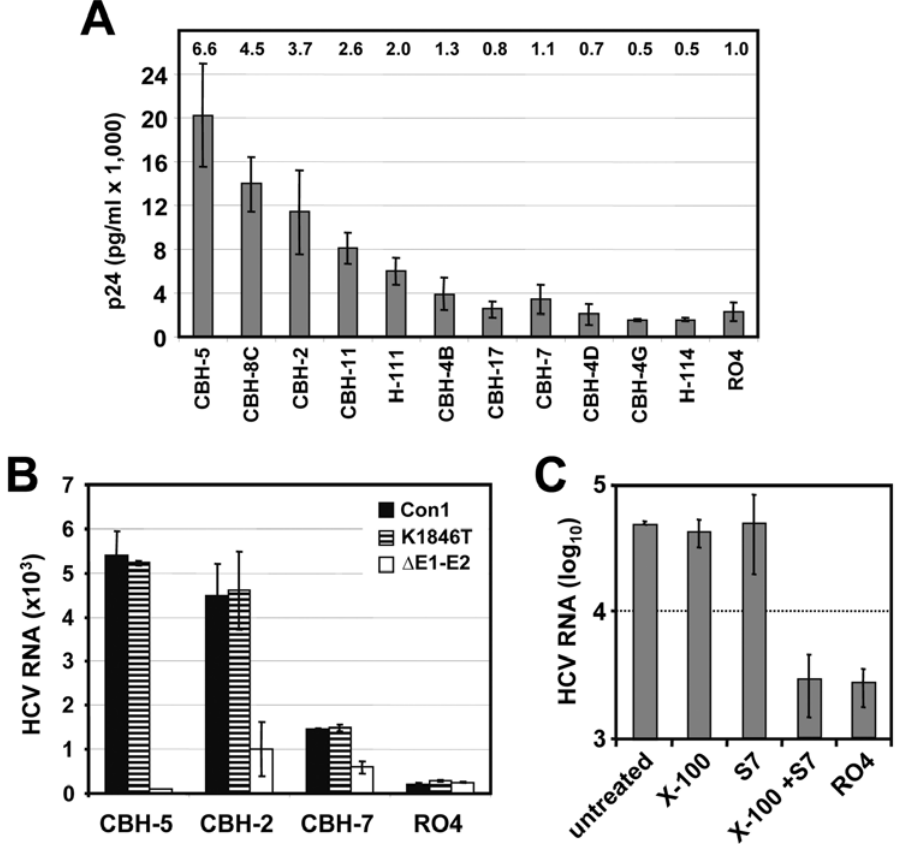
Figure 4. Capture of Con1 particles by E2-specific antibodies and characterization of captured particles. (A) Identification of monoclonal antibodies reacting with Con1 envelope glycoproteins. HCVpp carrying Con1 envelope glycoproteins were incubated with immobilized antibodies specified in the bottom and captured particles were quantitated by using p24-specific ELISA. Numbers above each bar refer to fold increase above background as determined by capture assay with an irrelavant antibody (RO4). Mean values of three experiments and the standard deviations are given. (B) Capture of HCV particles from supernatants of Huh-7 cells transfected with Con1/wt or Con1/K1846T or the Con1 mutant lacking most of the envelope glycoprotein coding region ( D E1–E2). Bound particles were quantified by using TaqMan qRT-PCR. Mean values of triplicate measurements including the standard error of the means are given. (C) Characterization of captured Con1/wt particles by nuclease treatment. Concentrated culture supernatant of Con1/wt transfected cells was used for capture with control antibody R04 (right bar) or CBH-5 (all other bars). Immune complexes obtained with the latter were split into 4 aliquots that were left untreated or treated with 0.5% Triton X-100, or nuclease S7, or 0.5% Triton X-100 and S7 nuclease. RNA was extracted and quantified by TaqMan